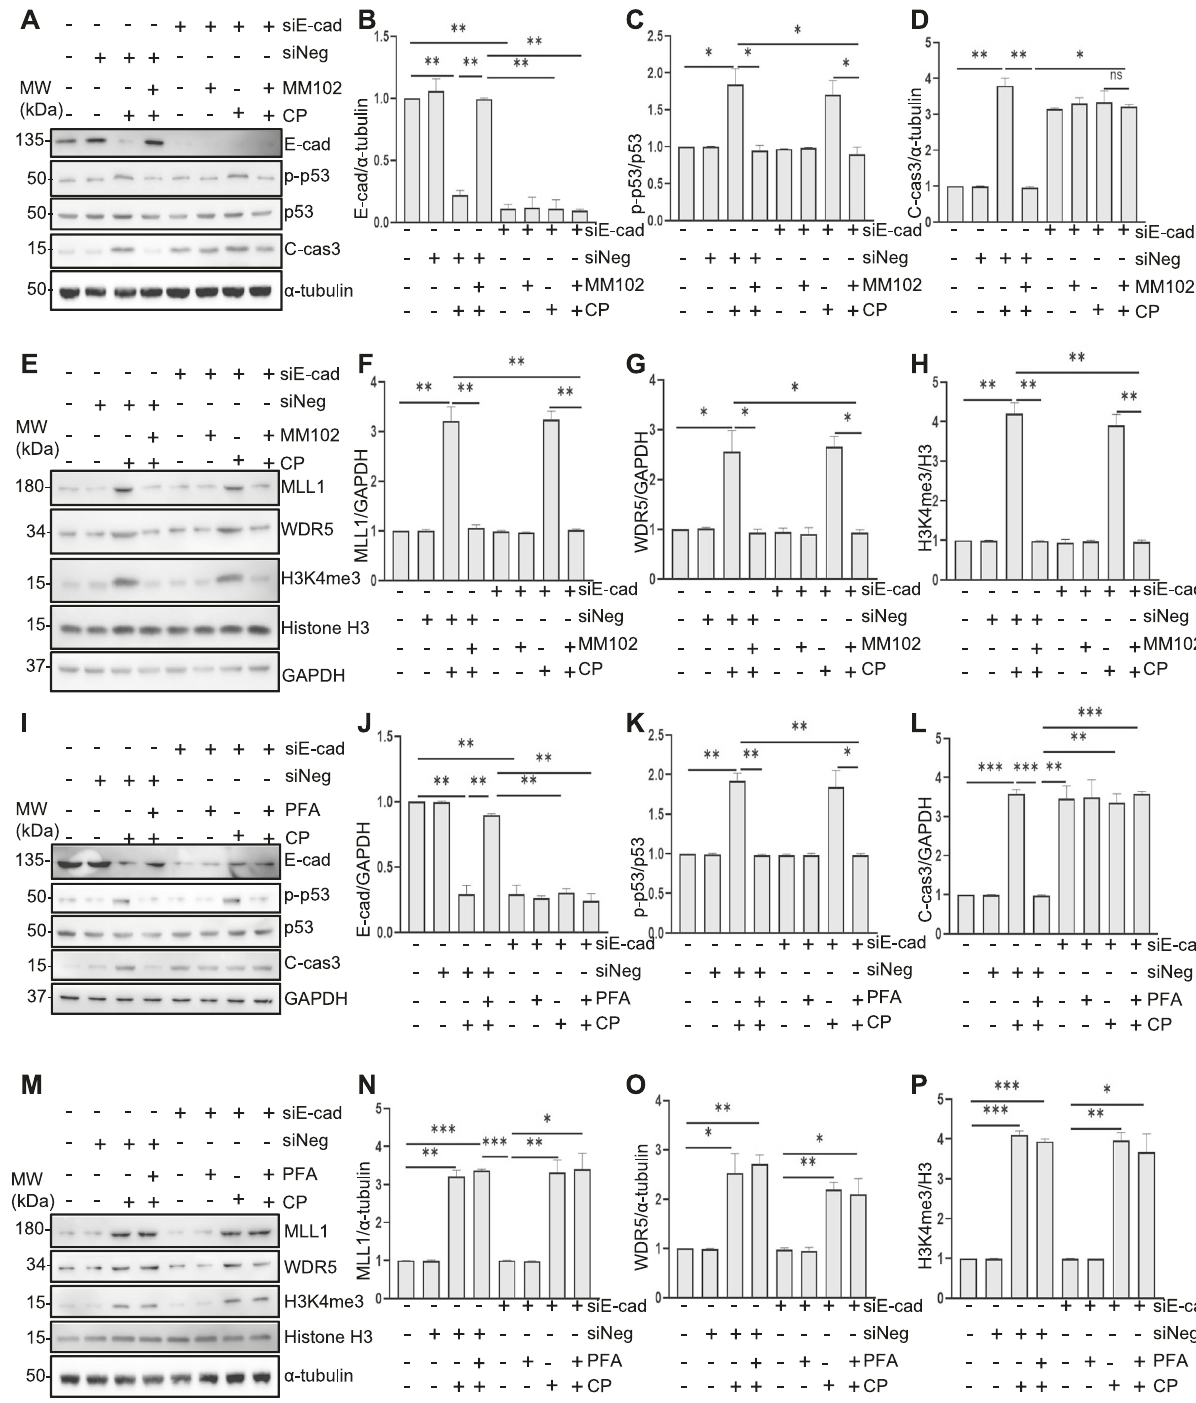
Fig. 5 E-cadherin (E-cad) silencing reduces the protective effect of MLL1/WDR5 inhibition in murine proximal tubular epithelial cells (RPTCs) exposed to cisplatin (CP). RPTCs were transfected with siRNA targeting E-cadherin (siE-cad) or negative siRNA (siNeg) and then treated with MM102 (50 μ M) or PFA (10 μ M) for 1 h and then exposed to CP (20 μ M) for an additional 24 h. A , I Cell lysates were prepared and subjected to immunoblot analysis with antibodies against E-cad, phospho-p53 (p-p53), p53, cleaved caspase3 (C-cas3), and α -tubulin. Expression levels of all those proteins were quanti fi ed by densitometry and E-cad ( B , J ), C-cas3 ( D , L ) were normalized with α -tubulin or GAPDH. p-p53 ( C , K ) was normalized with p53. E , M Cell lysates were prepared and subjected to immunoblot analysis with antibodies against MLL1, WDR5 and H3K4me3, and GAPDH/ α -tubulin. Expression levels of all those proteins were quanti fi ed by densitometry and MLL1 ( F , N ), WDR5 ( G , O ) were normalized with GAPDH/ α -tubulin. H3K4me3 ( H , P ) was normalized with histone H3. Values are mean ± SD. Signal obtained from the control (Ctrl) sample was set as 1. A representative result from at least three experiments was shown. * P < 0.05, ** P < 0.01, *** P < 0.001.